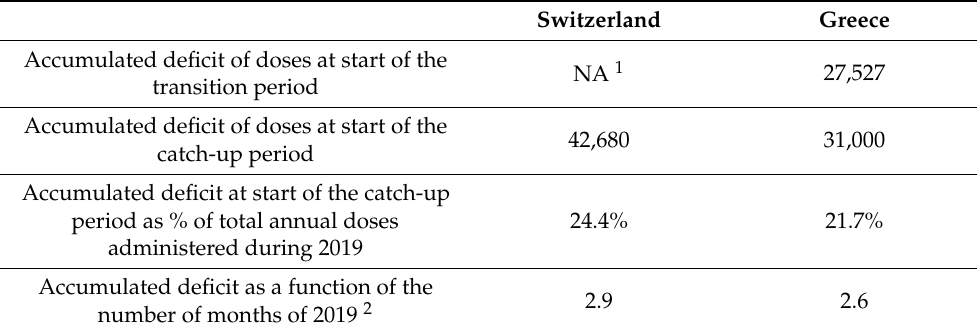
Table 1. Cumulative deficit of HPV vaccine doses missed during the COVID-19 pandemic.